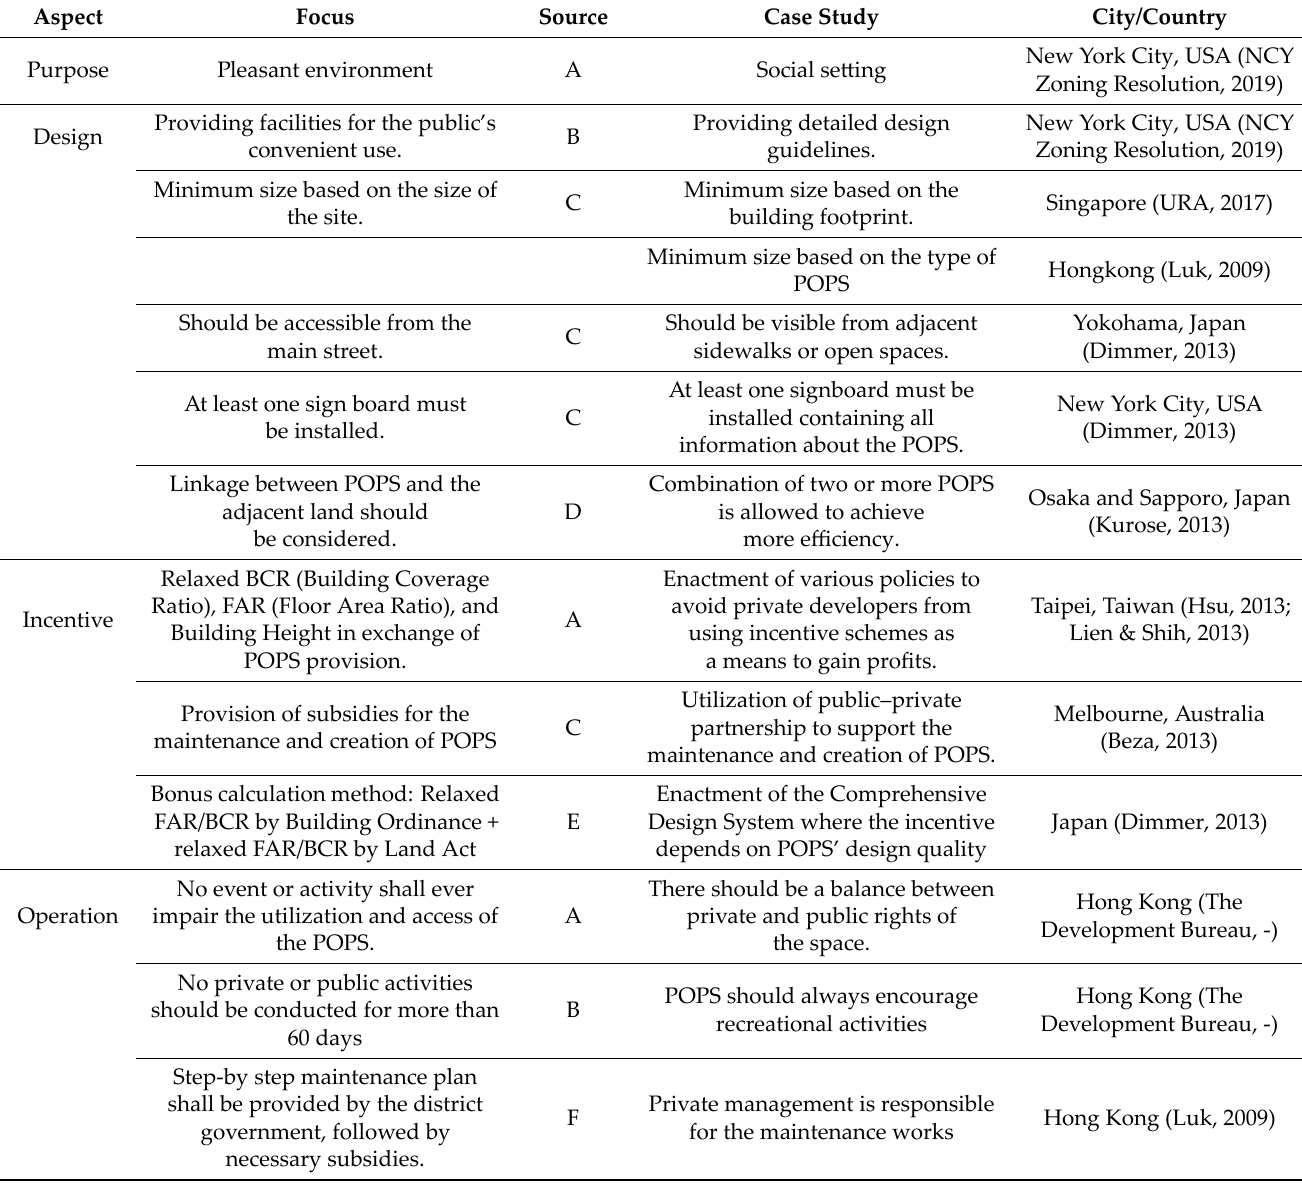
Table 3. Summary of the current POPS regulations in Seoul and relevant case studies as